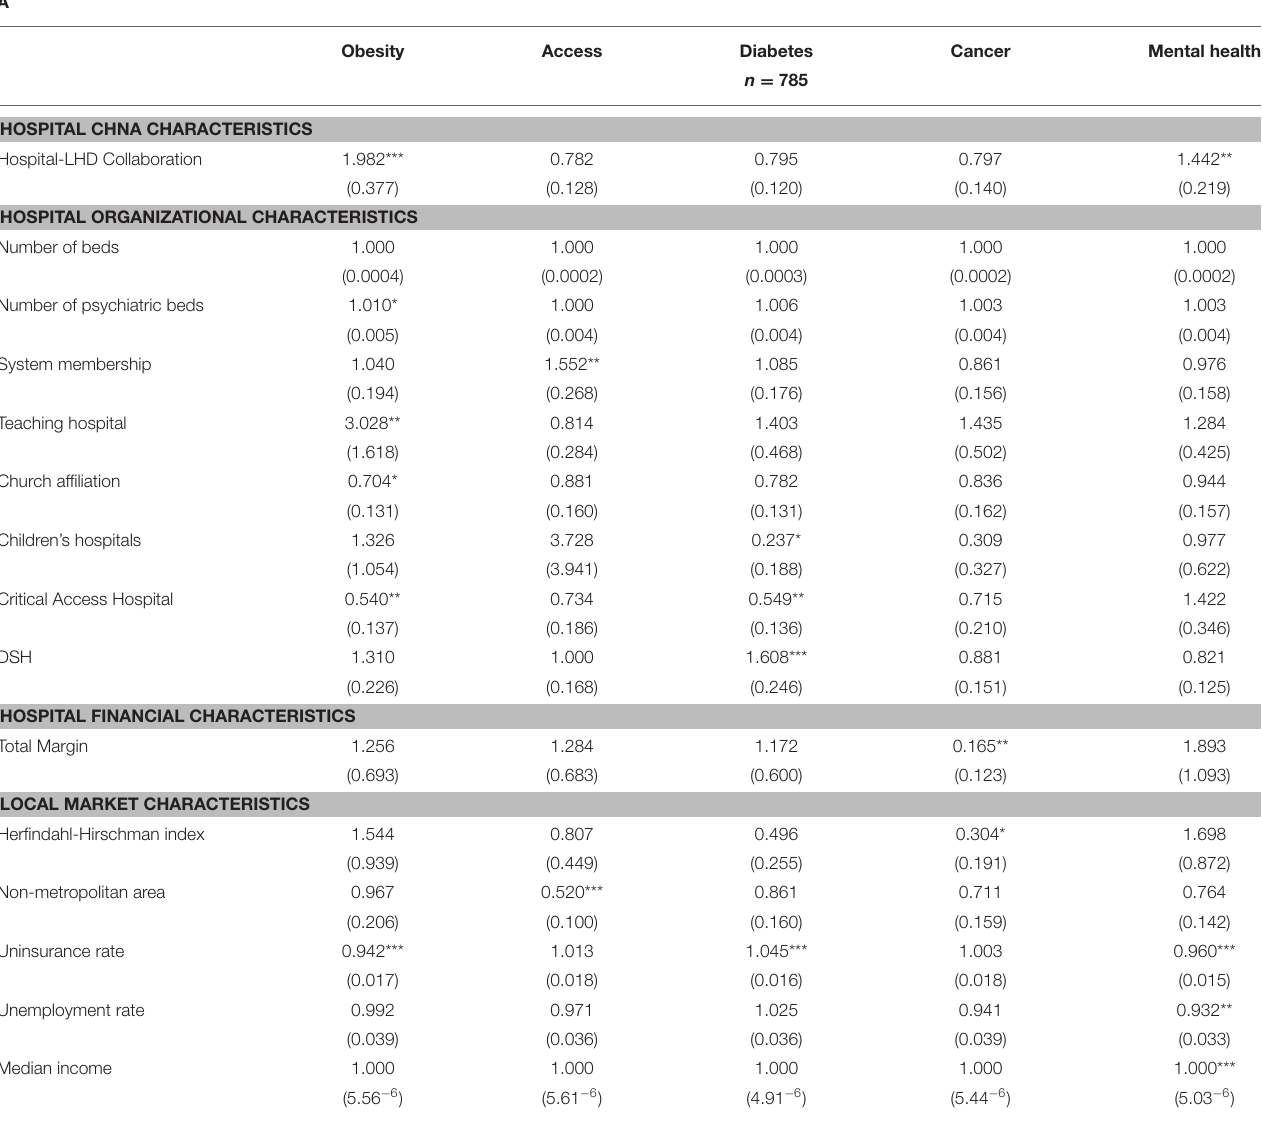
TABLE 3A | Bivariate analyses: association of targeted priority with hospital and county characteristics. A Obesity Access